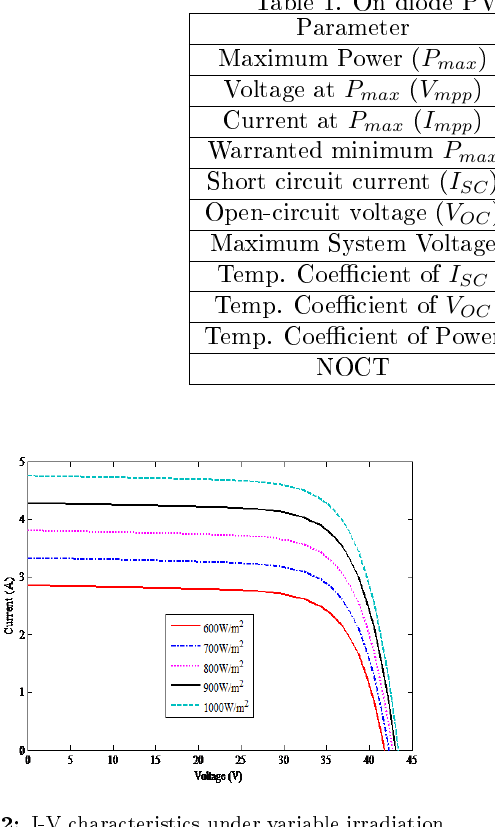
Fig. 2: I-V characteristics under variable irradiation.